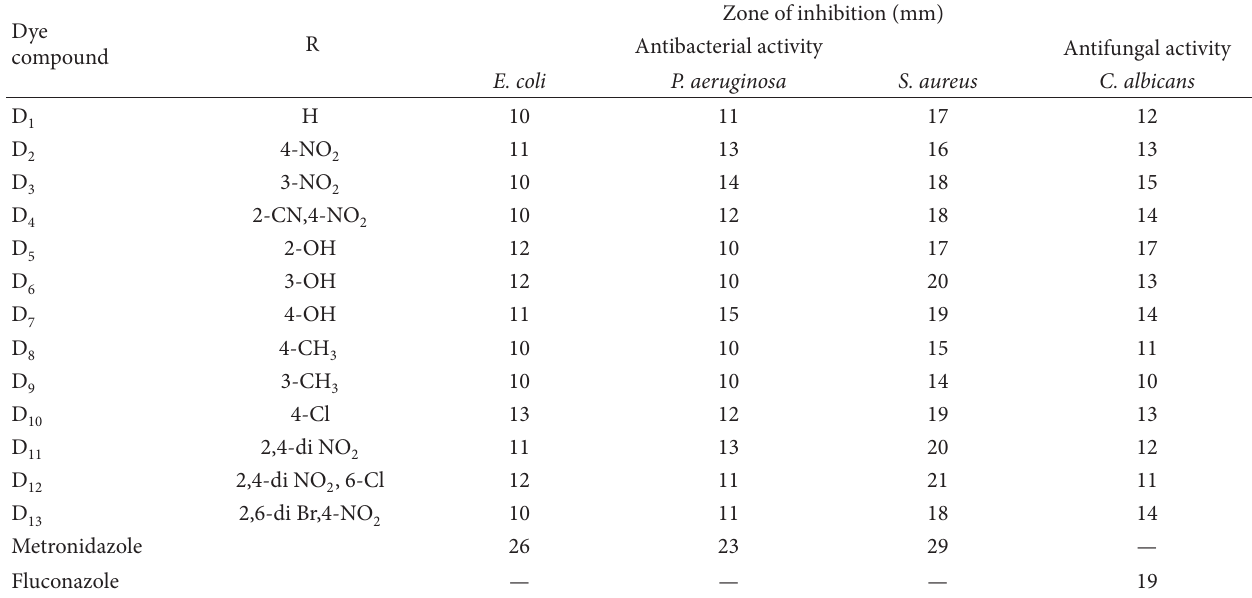
T 3: Antimicrobial screening results of disperse